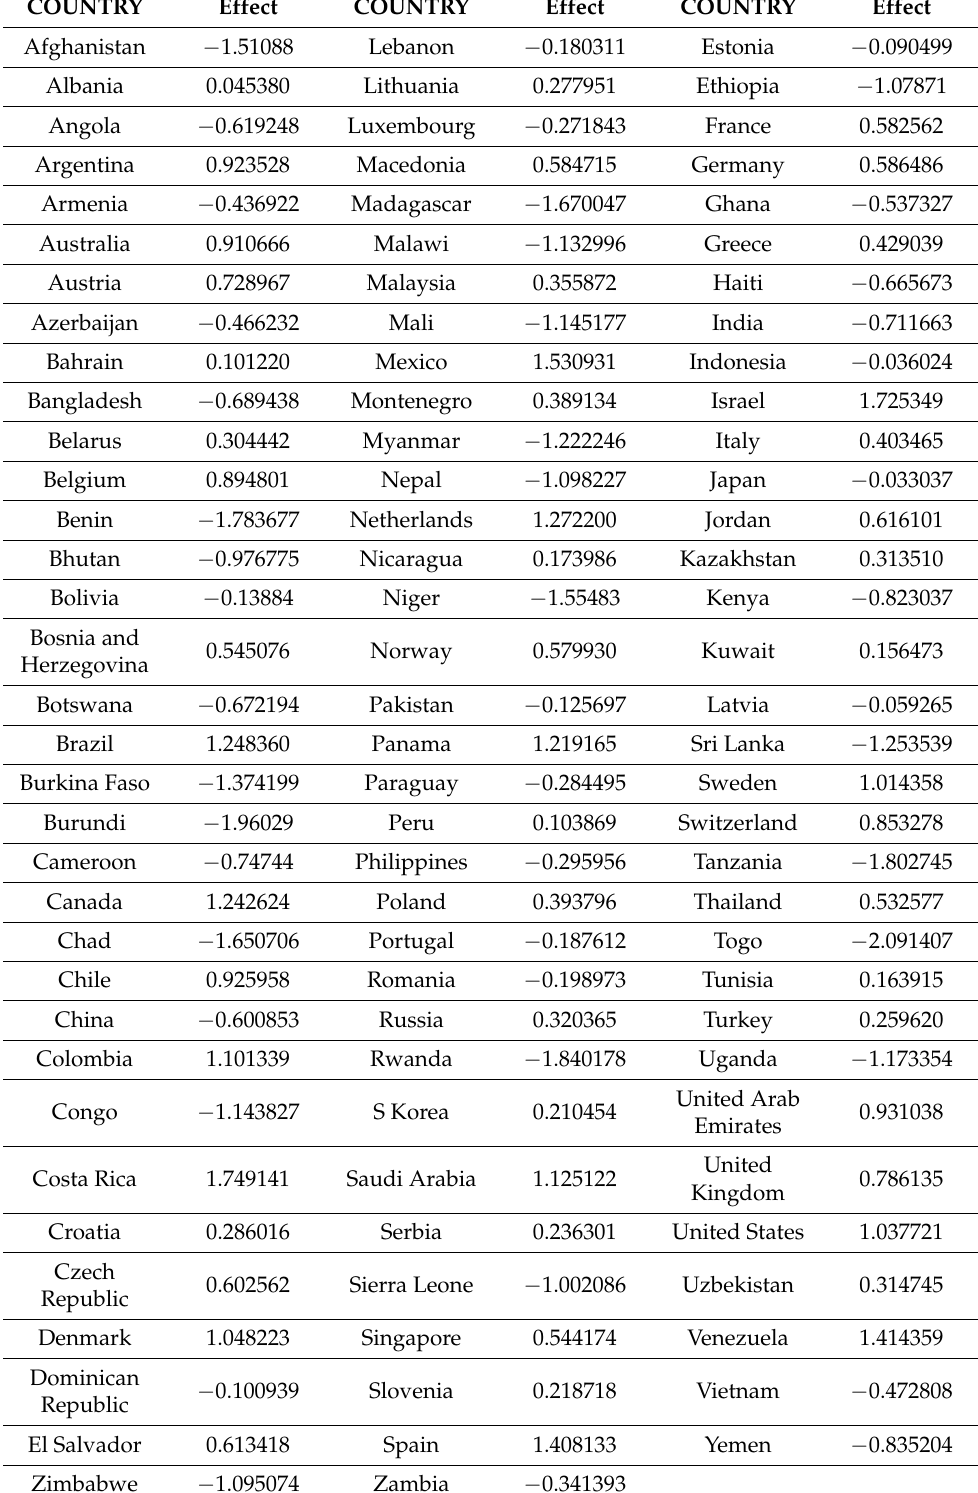
Table 3. The effect value of divergent countries in the same period.